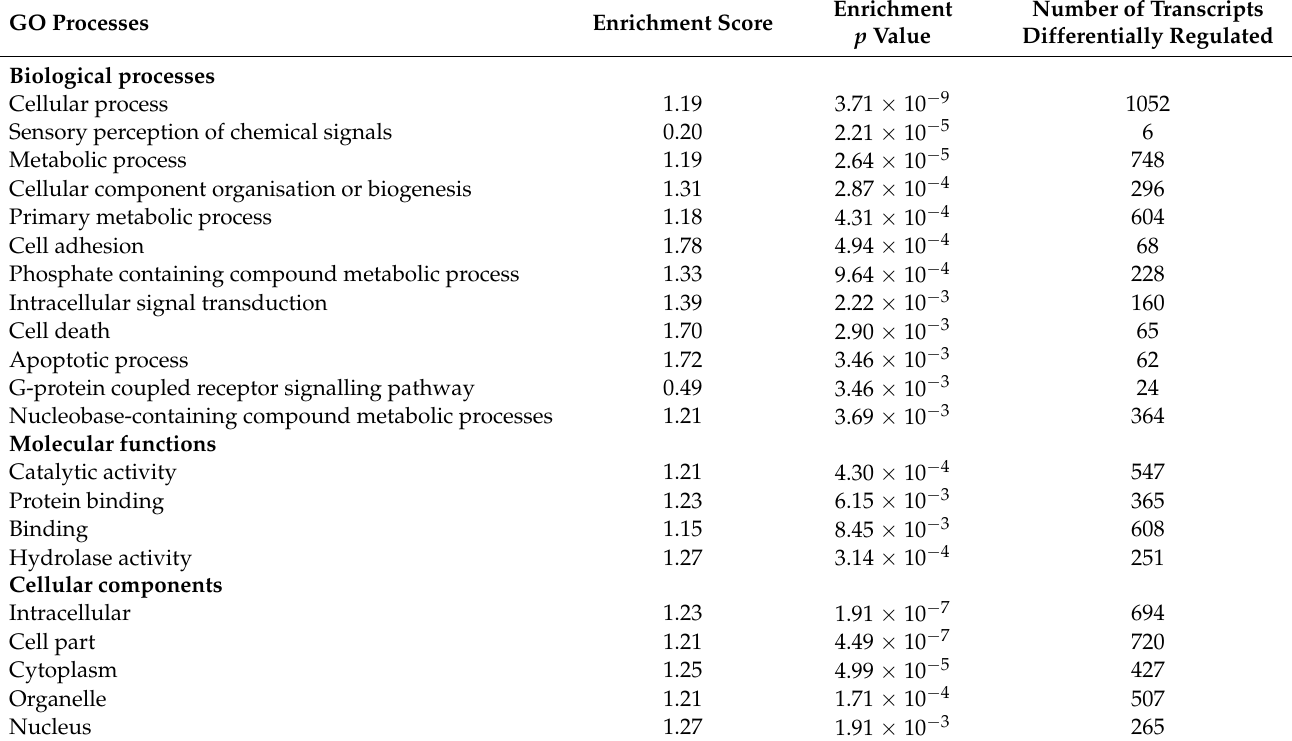
Table 3. GO enrichment analysis of transcripts regulated by high magnesium concentration. Anal- ysis applied FDR p < 0.005 for enrichment p values.